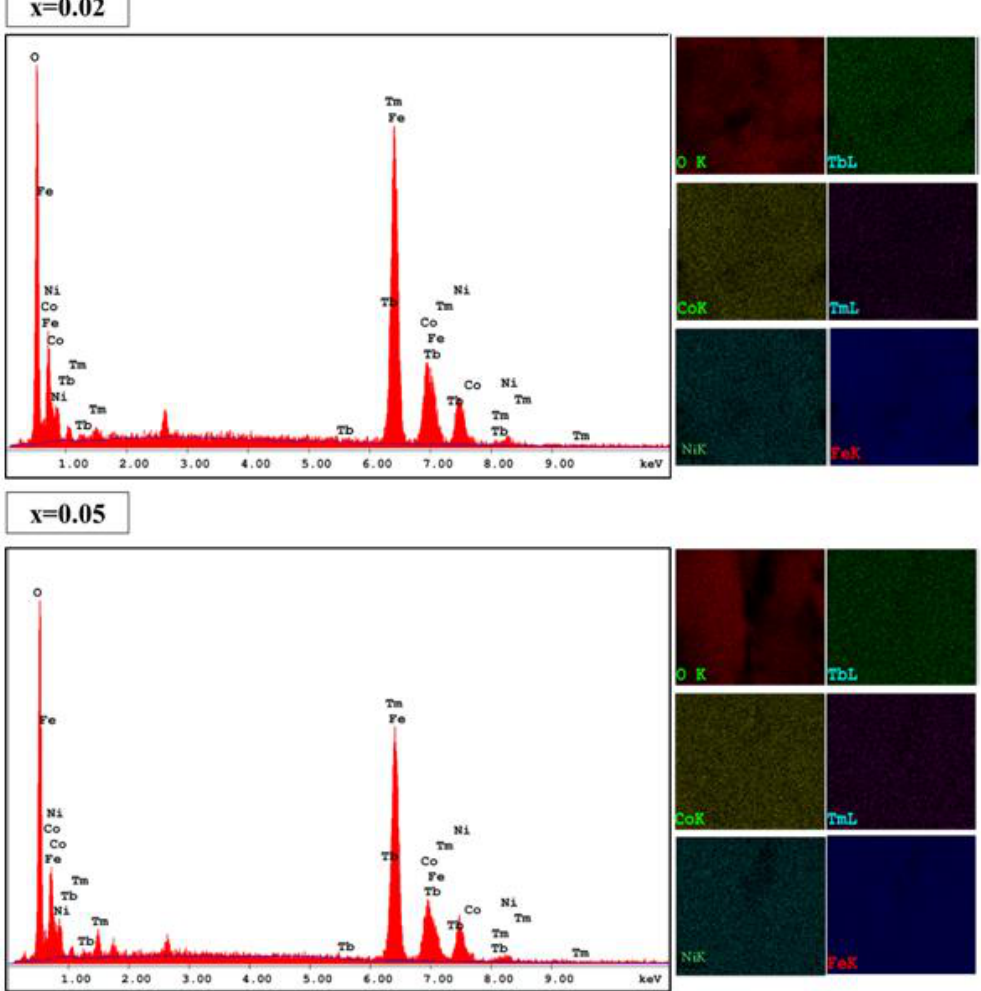
Figure 3. EDX spectra and elemental mappings of (Co 0.5 Ni 0.5 )[Tm x Tb x Fe 2−2x ]O 4 NSFs with x = 0.02 and 0.05.